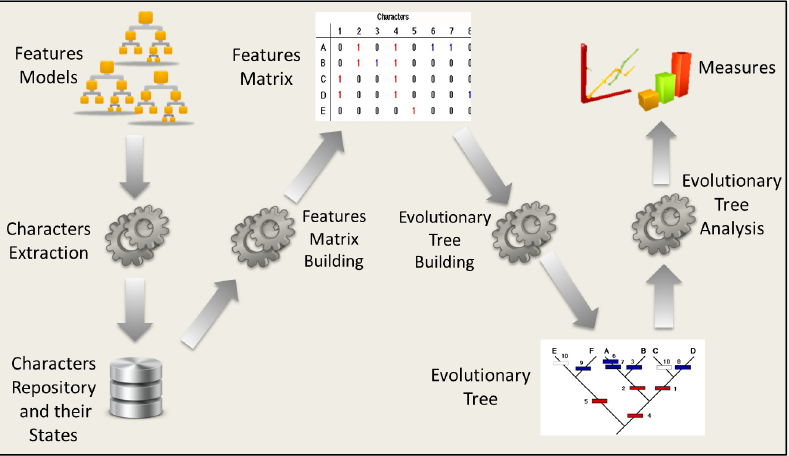
Figure 1. Cladistics classification for software product line